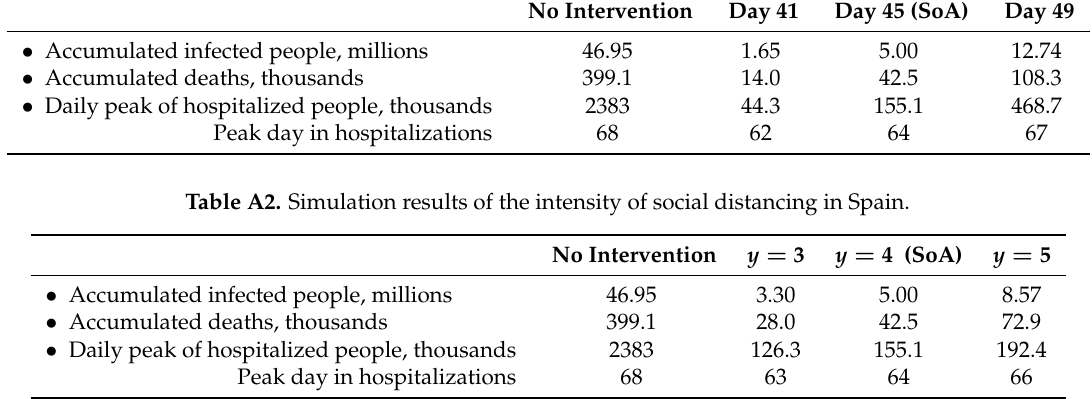
Table A3. Simulation results of the duration of the COVID-19 epidemic in Spain. No Intervention SoA Early SoA Tighter SoA 60